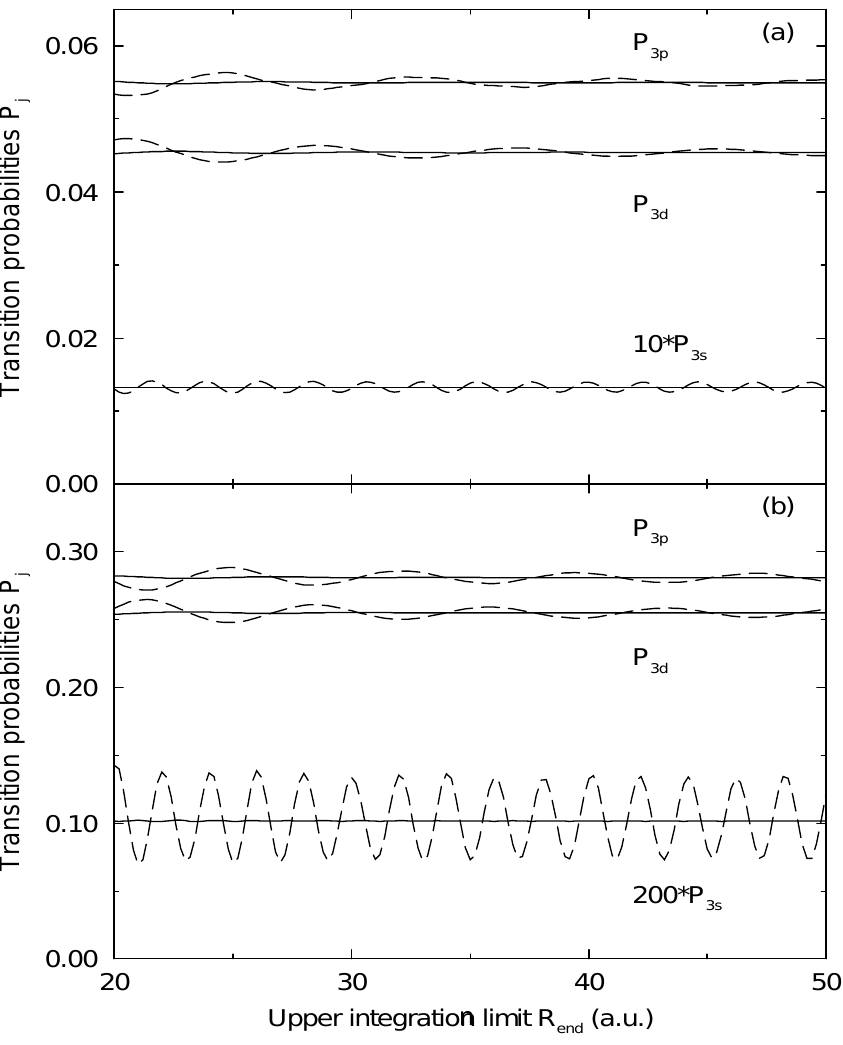
Figure 2: The transition probabilities for excitation of the C 3+ ( nl ) states in H + C 4+ (a) and D + C 4+ (b) collisions as functions of the upper integration limit R E = 10 eV/amu and the impact parameters b = 1 . 06 a.u. (a) and b = 1 . 87 a.u. (b). The solid lines are the results obtained by means of the t/τ -matrix approach, the dashed lines are calculations with neglection of the electron translation ( τ ± =